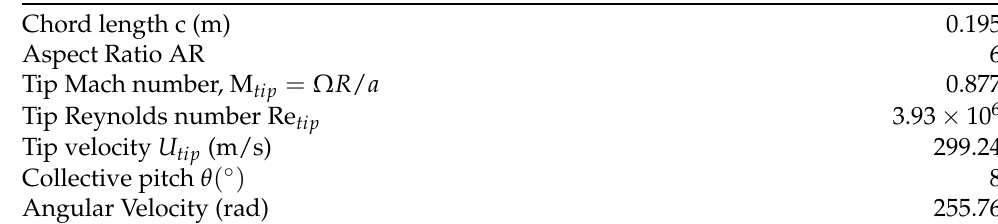
Figure A3. Configuration of the mesh for validation: ( a ) blade block; ( b ) voxel farfield block. Table A2. Flow condition for validation.